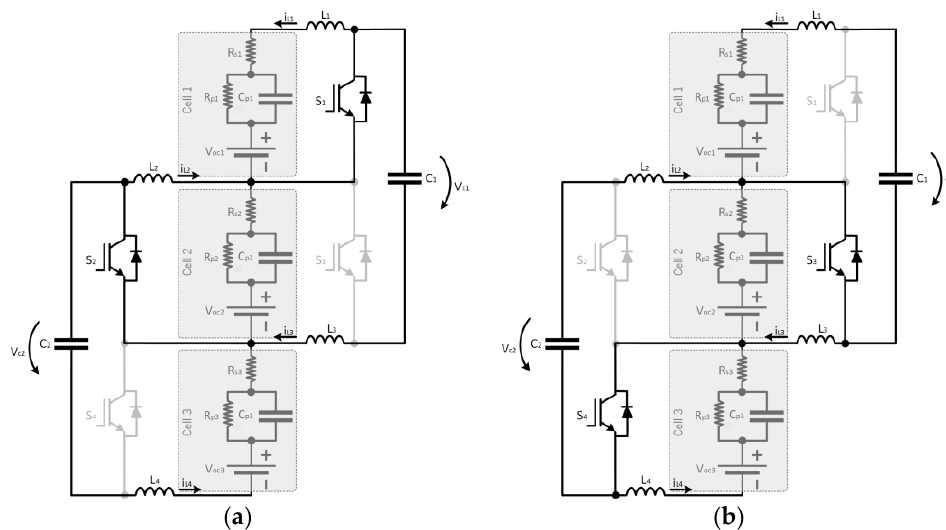
Figure 15. Operating modes of the Cuk converter: ( a ) first stage, T 1 ; ( b ) second stage, T 2 .